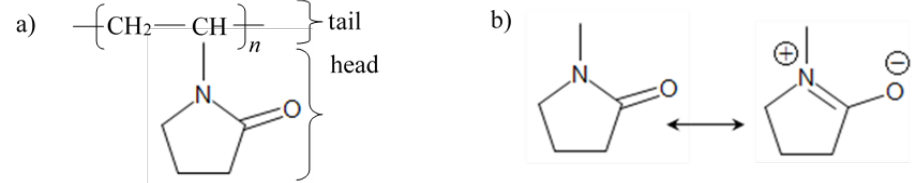
Figure 1. ( a ) PVP chemical structure; ( b ) formation of the resonance structure of the pyrene ring of PVP.